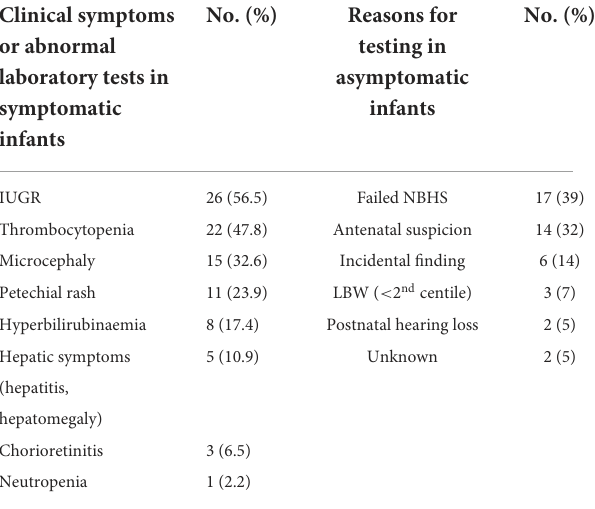
TABLE 2 Reasons for testing for CMV. TABLE 3 Timings of diagnostic test, referral and treatment initiation and reasons for delayed treatment